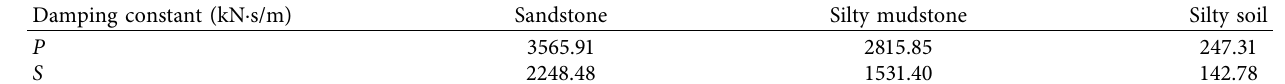
Table 4: Damping constant of every strata.